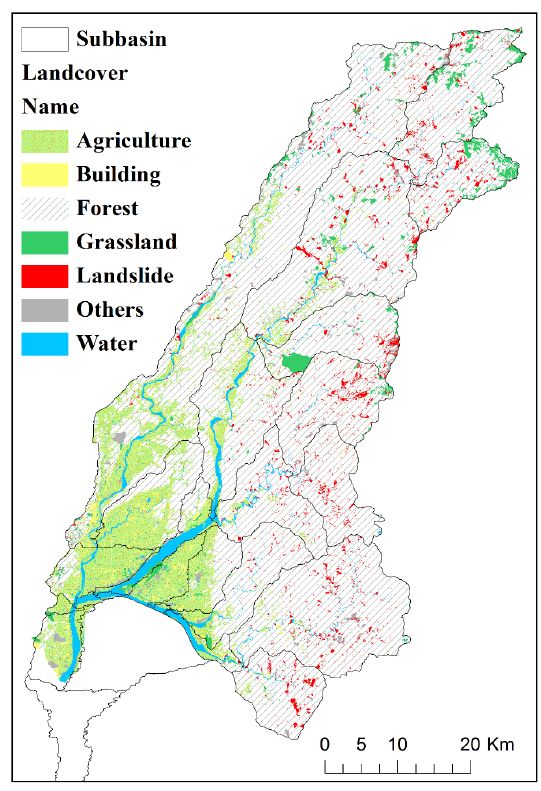
Figure 4. Landslide updating result of the National Land Surveying and Mapping Center (NLSC) land-use survey of the GRD catchment,